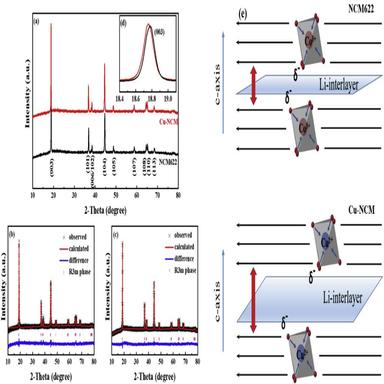
XRD patterns of NCM622 and Cu-NCM powders (a), the Rietveld-refinements of NCM622 (b) and Cu-NCM (c) samples. The enlarged XRD patterns of (003) peak (d) in (a). Illustration of Cu doping effects in the movement of the Li-interlayer along the c-axis (e).